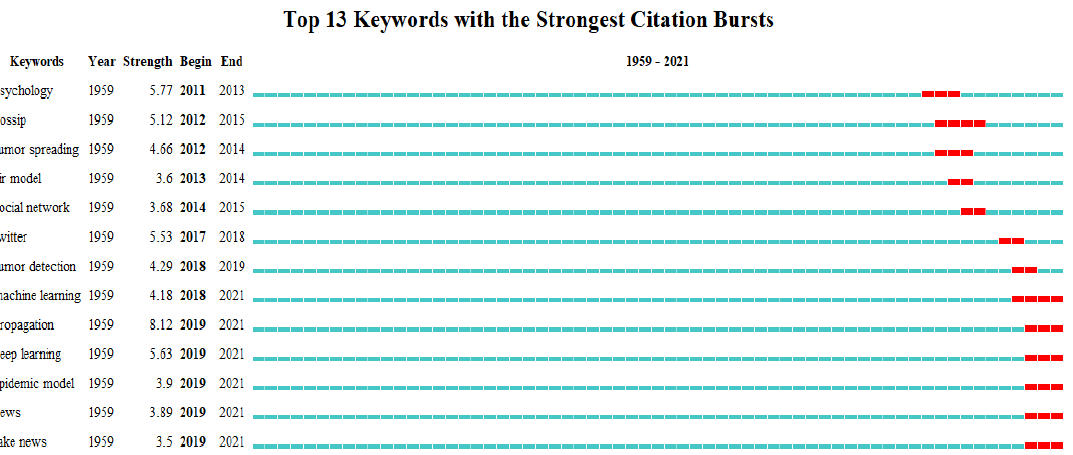
Figure 2. Top 13 keywords with the strongest citation bursts in the WOS database.